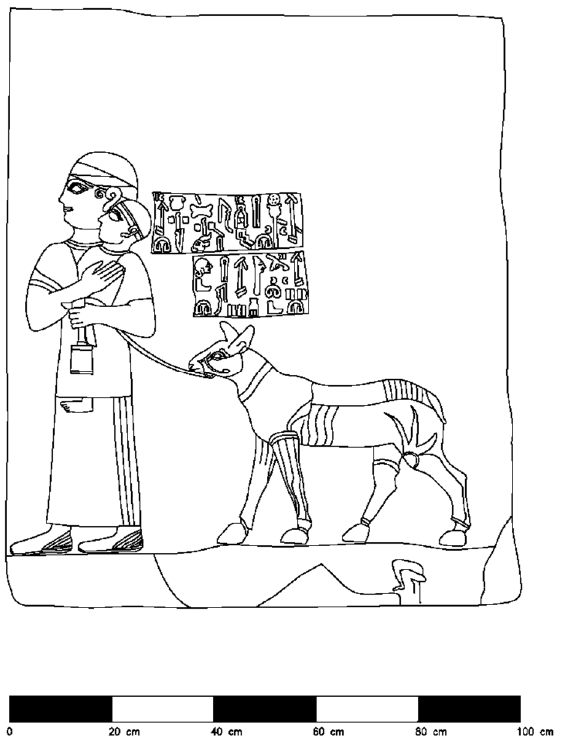
Figure 13. Royal Buttress, Slab B8a: unidentified official carrying the infant prince Tuwarsais, holding a seal(?) and leading a donkey on a leash (drawing by Elia Bettini).